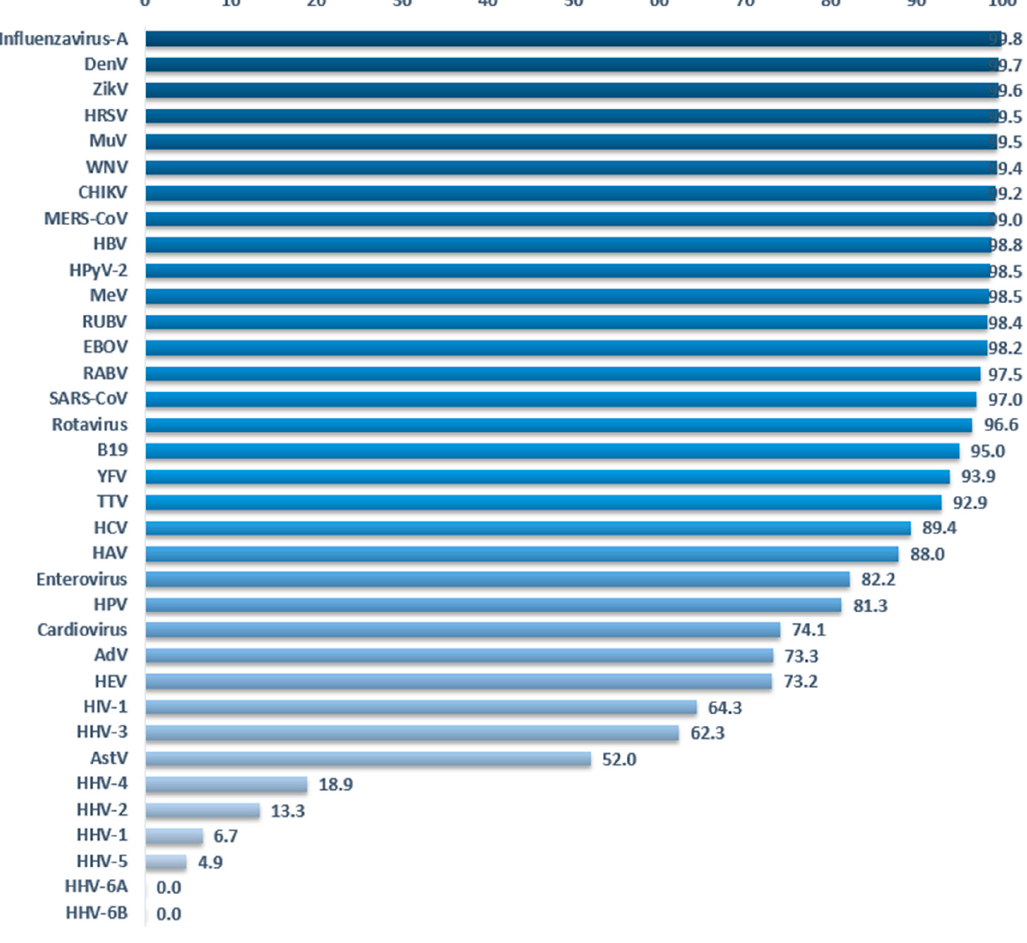
Figure 5. Percentage of sequence reduction by clustering complete genomes at 90%. (Data Virosaurus 2019_10).